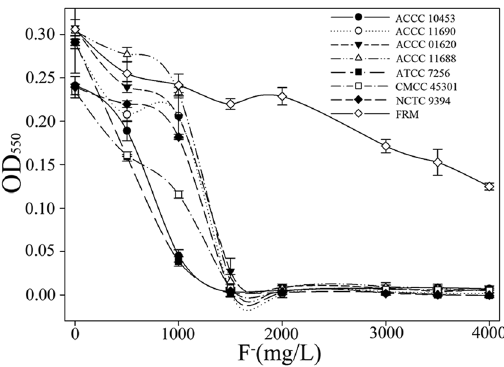
Figure 1. Growth of Enterobacter cloacae strains (FRM, ACCC 10453, ACCC 11690, ACCC0 1620, ACCC 11688, ATCC 7256, CMCC 45301, and NCTC 9394) at varying concentrations of